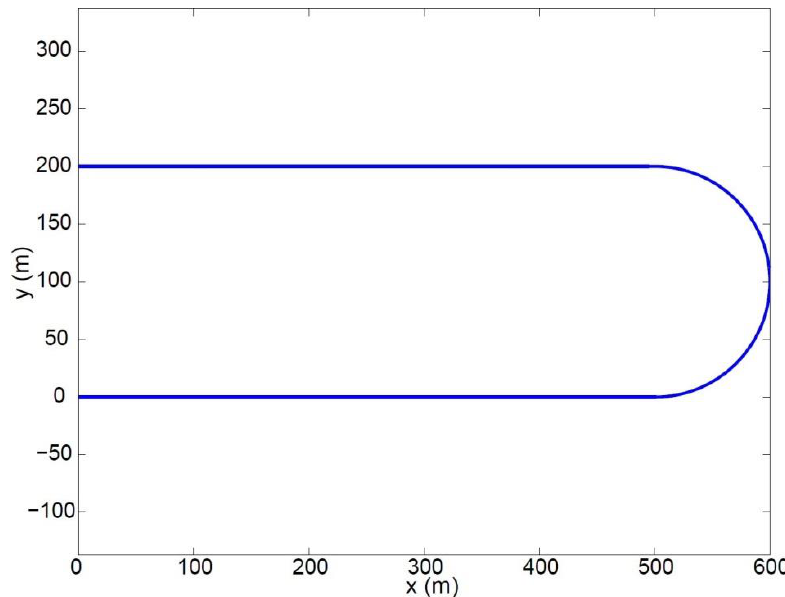
Figure 10. Straight lines and hairpin bend path.